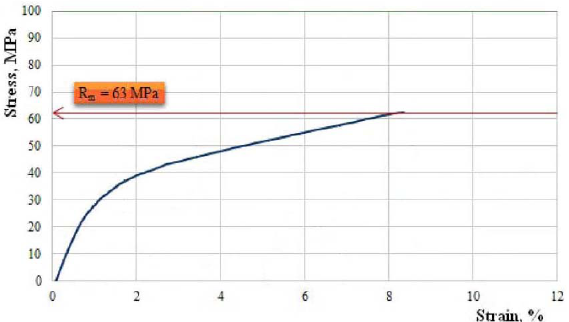
Figure 11. The characteristic curve of a representative sample of cotton fabric-reinforced composite material. Tensile strength R m = 63.0 MPa; elongation at break A = 8.4%; modulus of elasticity E = 3415